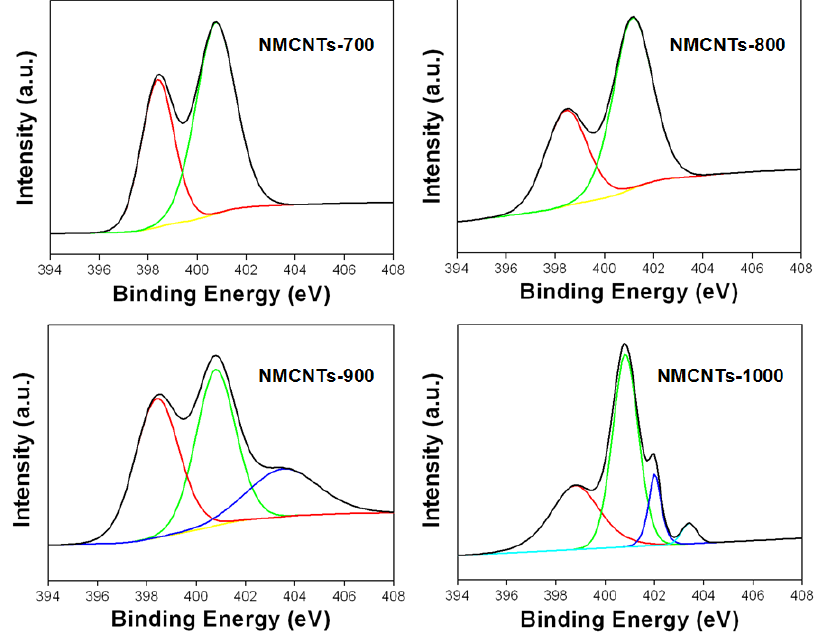
Figure 4. X-ray photoelectron spectroscopy (XPS) N 1s spectra of NMCNTs-700, -800, -900 and